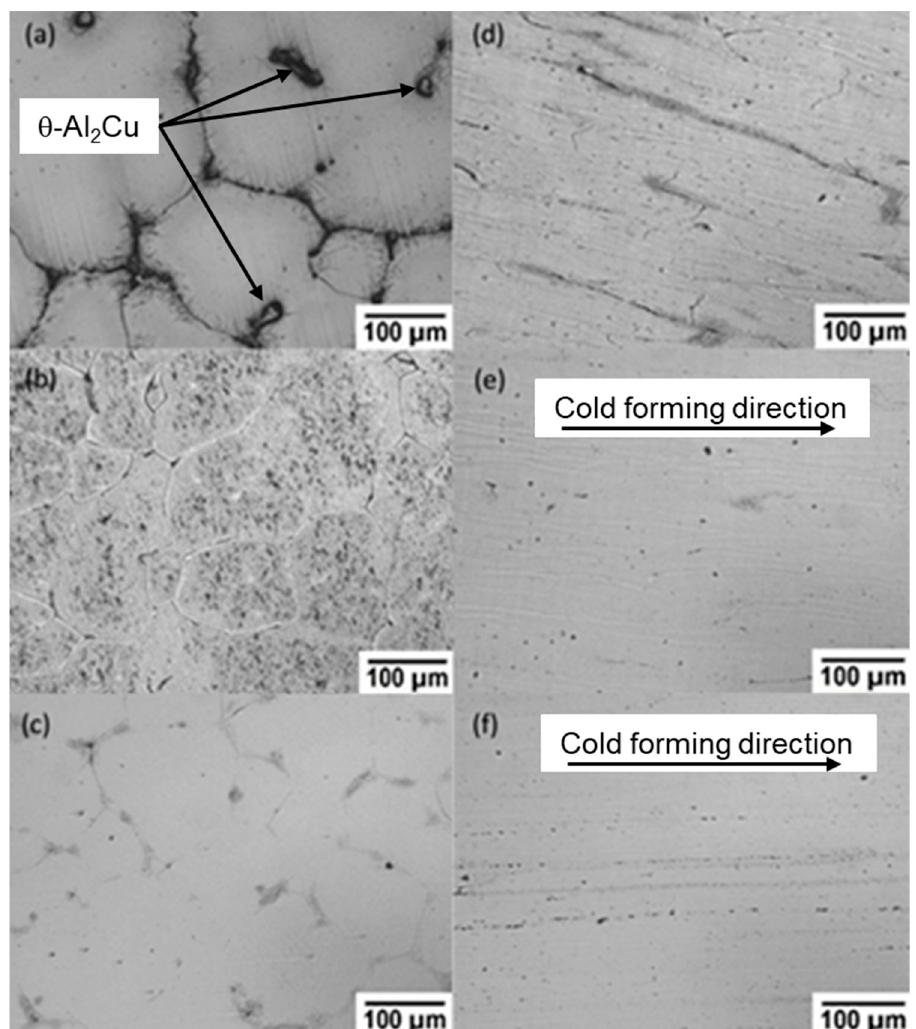
Figure 1. ( a ) A206 master alloy; ( b ) Al–0.5 wt. % Mg–20 wt. % A206; ( c ) Al–0.5 wt. % Mg–20 wt. %